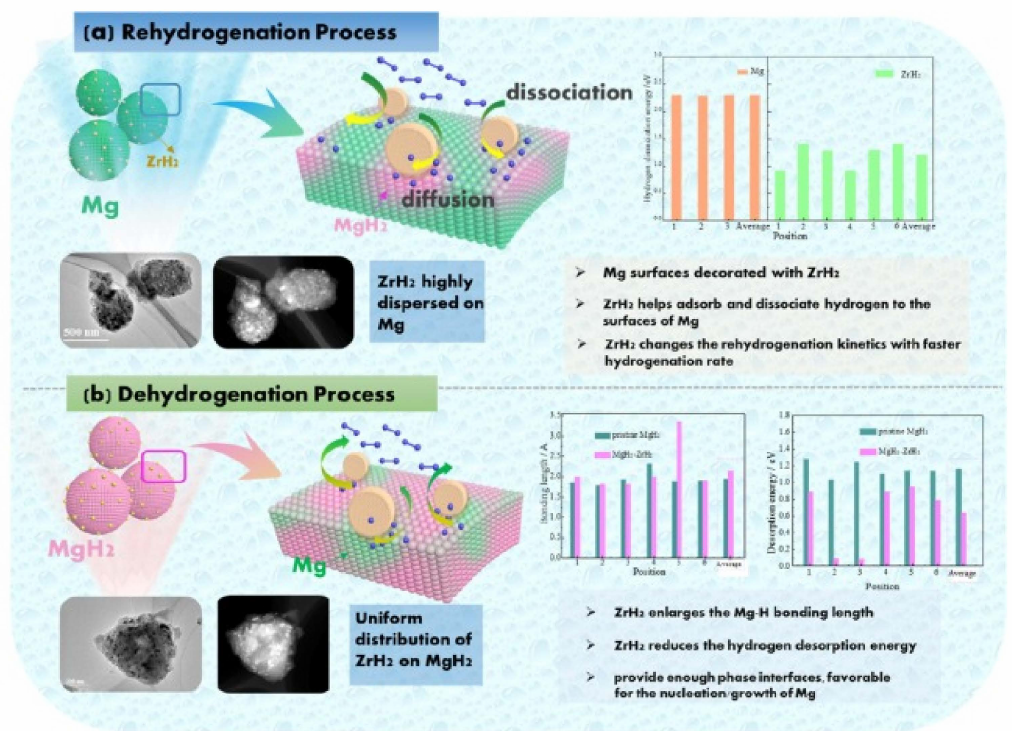
Figure 14. ( a ) The schematic of the rehydrogenation and ( b ) dehydrogenation processes of MgH 2 -ZrH 2 [113]. (Reprinted with permission from Elsevier).